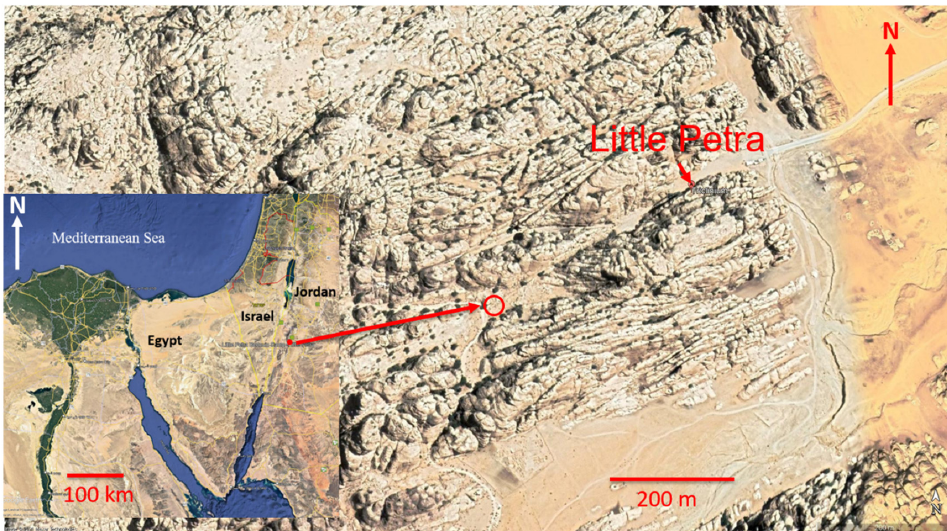
Figure 2. A regional map (lower left corner), with an extension of the study site, near Little Petra, Jordan. The topography is dominated by sandstone mountains and deep wadis between them. The study site is marked by a red